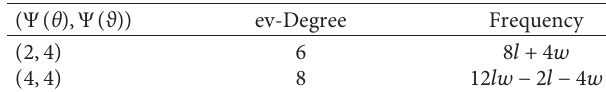
Table 3: End vertices’ ve-degrees of each edge of G